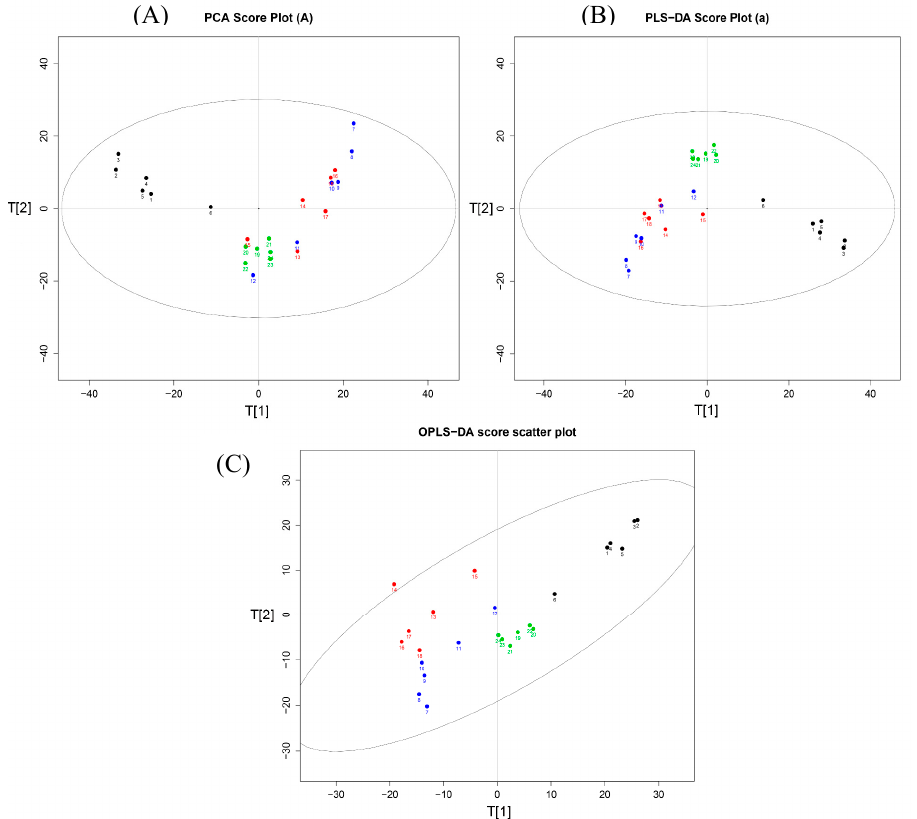
Figure 5. ( A ) Score plots of principle component analysis (PCA), ( B ) partial least-squares discriminant analysis (PLS-DA) and ( C ) orthogonal partial least-squares discriminant analysis (OPLS-DA) analysis on the fever rat serum metabolic profiles of normal control (black dot), model (blue dot), SB treatment (red dot) and NB treatment group (green dot).